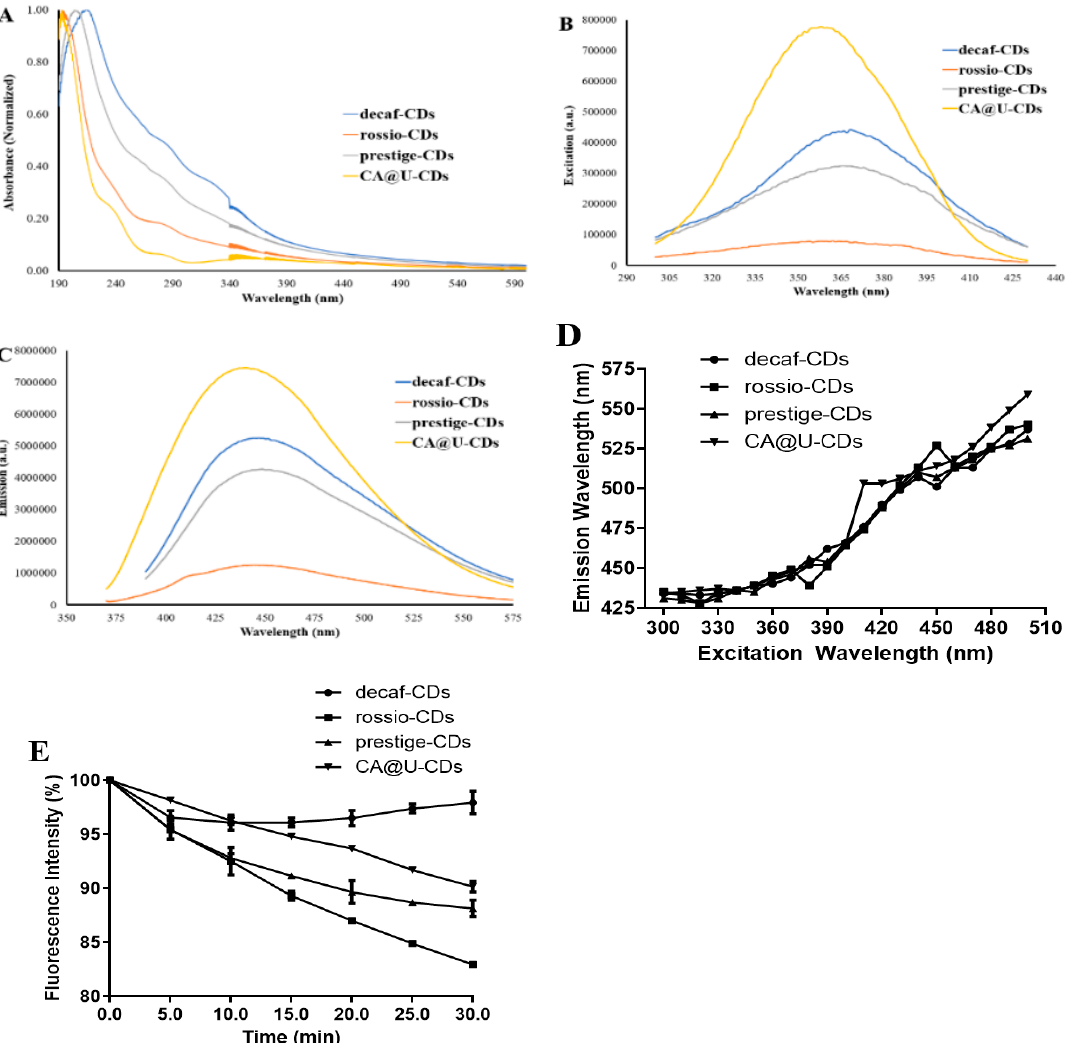
Figure 2. ( A ) Absorption, ( B ) excitation and ( C ) fluorescence spectra in aqueous solution for decaf-CDs, rossio-CDs, prestige-CDs and CA@U-CDs. ( D ) Emission wavelength (in nm) as a function of the excitation wavelength (in nm). ( E ) Photostability of the four CDs, measured as the variation of the fluorescence intensity as a function of irradiation time under a UV light source (365 nm).